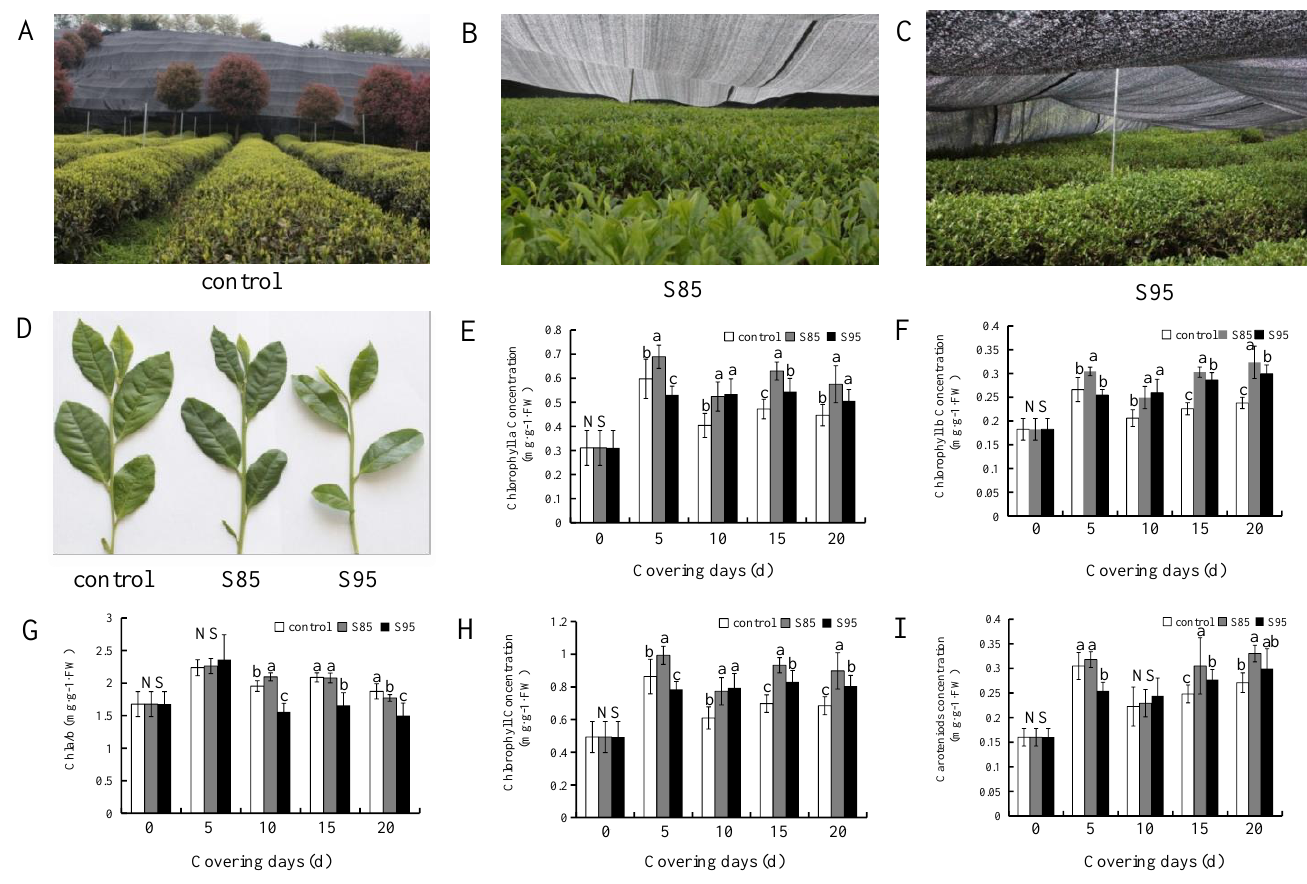
Figure 1. Effects of shading on the appearance as well as the chlorophyll and carotenoid contents of tea plants. ( A ) Open-air (control) tea plants ( B ) Tea plants grown under 85% shade ( C ) Tea plants grown under 95% shade ( D ) Appearance of tea plant leaves after 20 days of growth ( E ) chlorophyll a content ( F ) Chlorophyll b content ( G ) Chlorophyll a/b ratio ( H ) Total chlorophyll content ( I ) Carotenoid content. ‘NS’ and different letters above the bar indicate insignificant and significant ( p < 0.01; n = 3 biological replicates) differences, respectively, between the control and shaded plants.